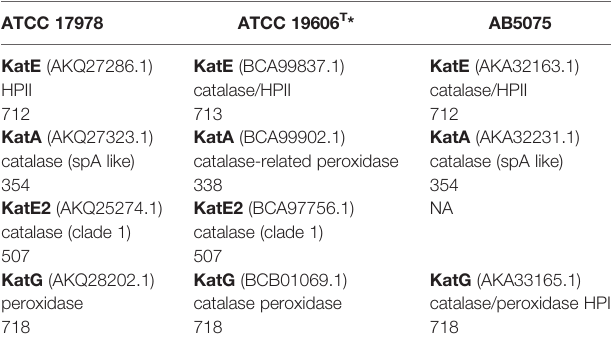
TABLE 3 | Catalase homologs in the A. baumannii strains ATCC 17978, ATCC 19606 T , and AB5075. The format includes name (Protein ID), annotated function, and